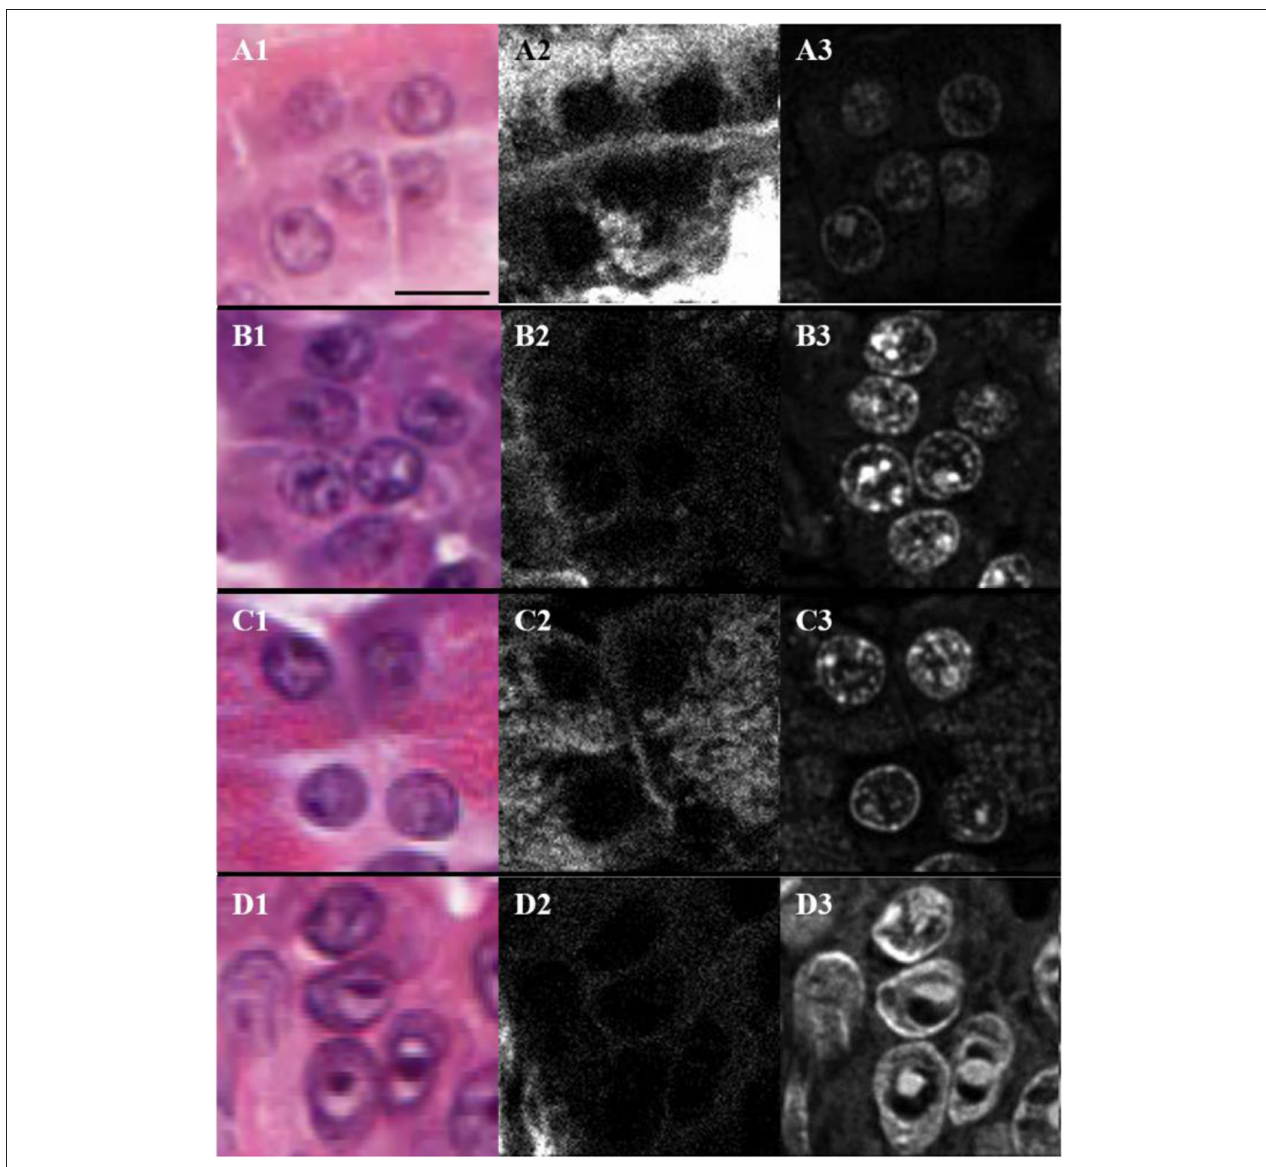
FIGURE 4 | Bright-field (A1,B1,C1,D1) , SHG (A2,B2,C2,D2) , and THG (A3,B3,C3,D3) images of nuclei present in the periductal (A) , lobular (B) and parenchymal (C) regions of normal pancreas as well as in tumor (D) where the scale bar represents 10 µ